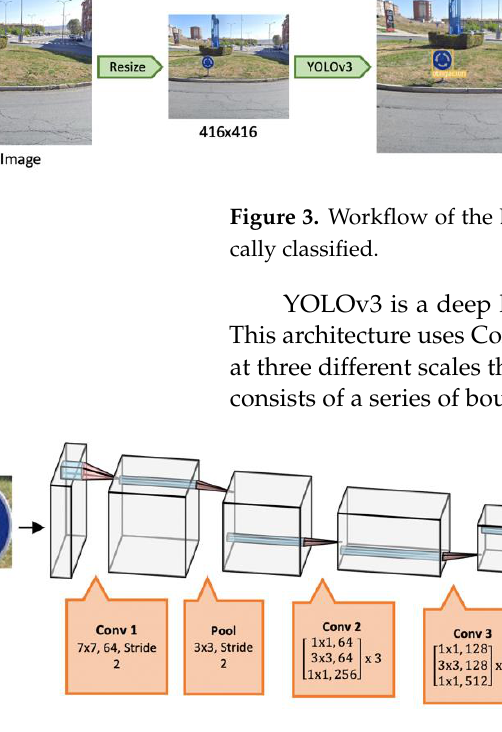
Table 1. Training Table 1. Training parameters.